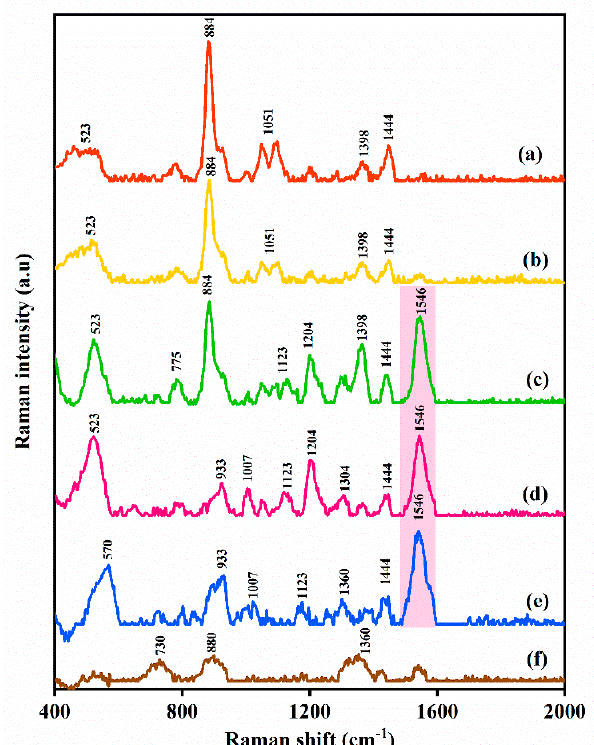
Figure 4. SERS spectra of ( a ) human blood plasma spiked with paracetamol (PCM); ( b ) PCM reference spectrum in ethanol; ( c ) human blood plasma spiked with MPN and PCM; ( d ) human blood plasma spiked with MPN (positive control); ( e ) reference MPN spectrum in aqueous solution; ( f ) blank human plasma (negative control).